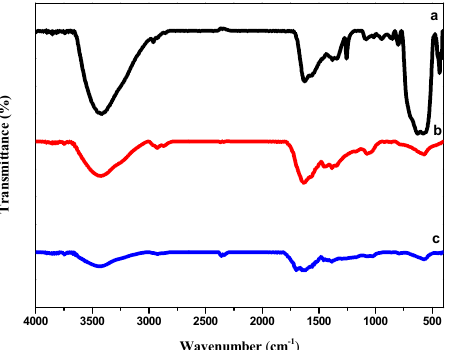
Figure 1. Fourier-transform infrared (FTIR) spectra of (a) Fe 3 O 4 , (b) Fe 3 O 4 @NC, and (c) Fe 3 O 4 @NC/Pd. The thermal stability of Fe 3 O 4 (a), Fe 3 O 4 @NC (b) and Fe 3 O 4 @NC/Pd (c) was then proved by TG